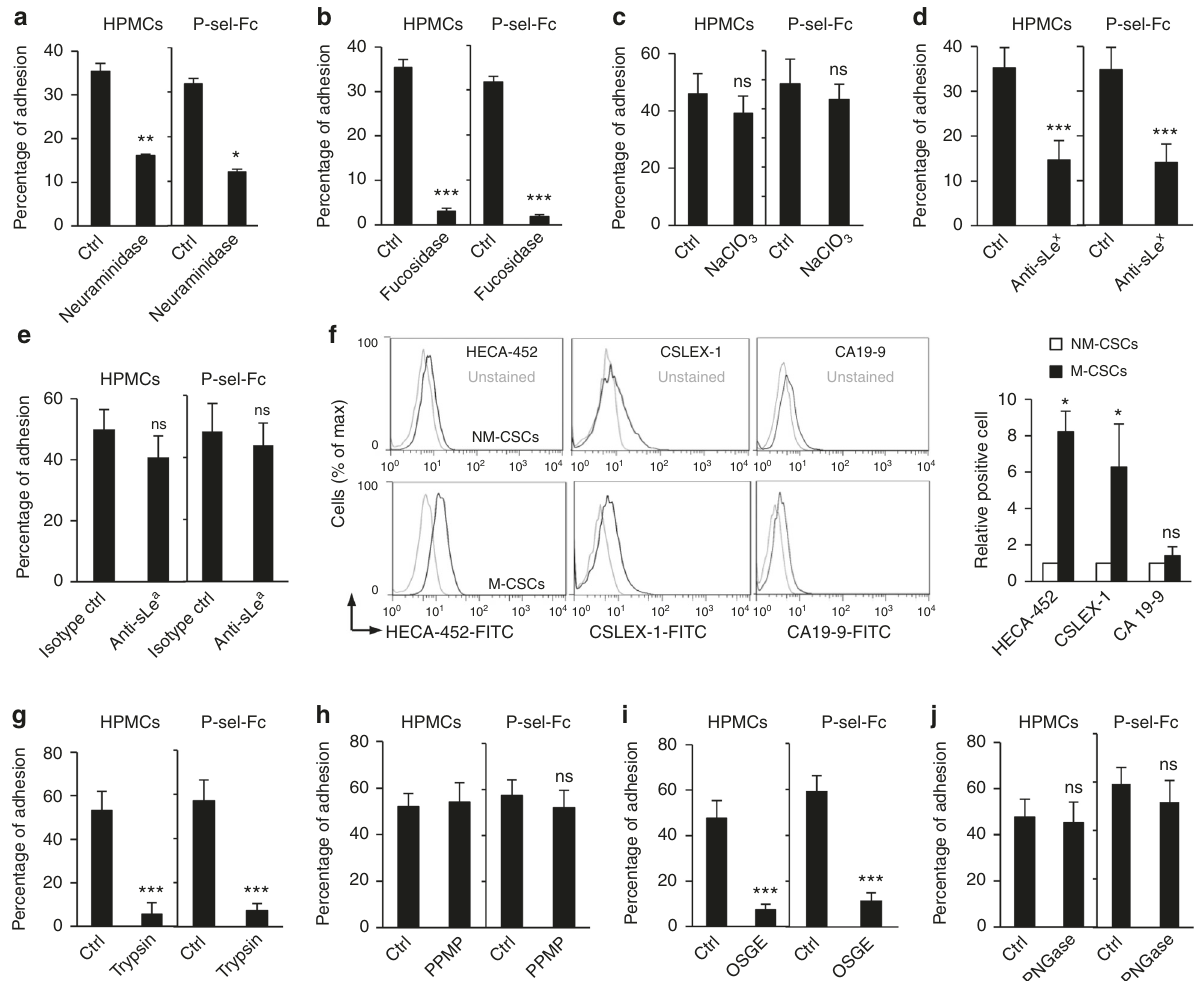
Fig. 4 sLe x mediates M-CSCs interaction with P-selectin on HPMCs. a – e Percentage of M-CSCs adhesion to HPMCs or P-selectin-Fc after treatment. a Neuraminidase treatment. n = 73/35, 46/108. b Fucosidase treatment. n = 98/153, 67/64. c NaClO 3 treatment. n = 49/65, 35/89. d Anti-sLe x treatment. n = 108/68, 89/71. e Anti-sLe a treatment. n = 108/68, 89/71. f Cell surface expression of sLe a/x on CSCs. Left: representative images of fl ow cytometry. Right: relative positive cell plot. n = 3. g – j Percentage of M-CSCs adhered to HPMCs or P-selectin-Fc after treatment. g Trypsin treatment. n = 32/36; 28/68. h PPMP treatment. n = 77/37, 54/46. i OSGE treatment. n = 42/109, 54/95. j PNGase treatment. n = 42/31, 54/31. Data (mean ± SEM) from one of three independent experiments, chi-square test a – e , g – j , or from three biological replicates, unpaired Student t test f . ns, not signi fi cant. * P < 0.05; ** P <